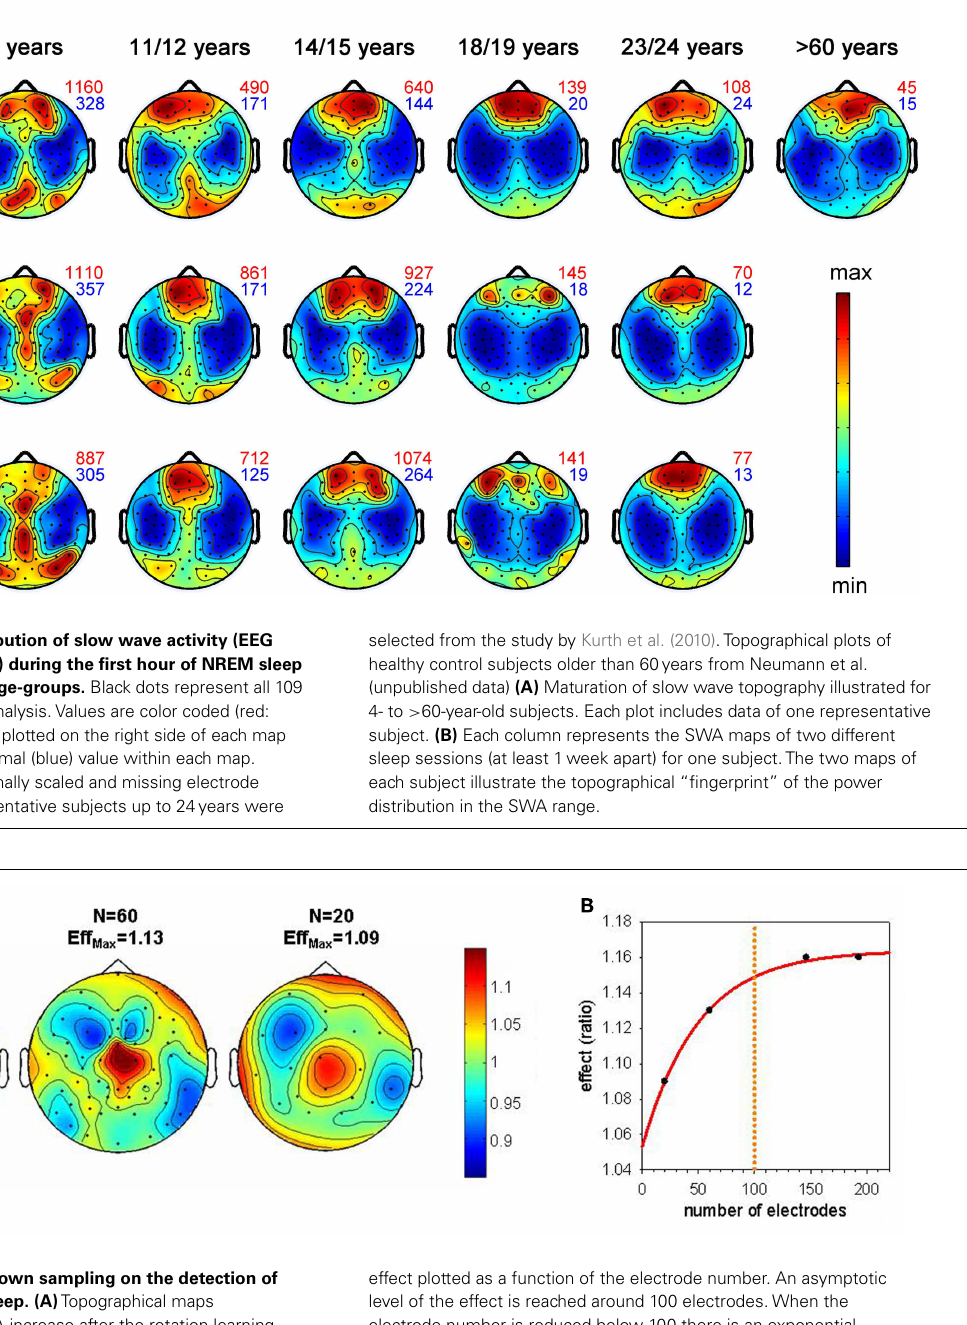
effect plotted as a function of the electrode number. An asymptotic level of the effect is reached around 100 electrodes.When the electrode number is reduced below 100 there is an exponential decrease in the size of the effect.This pronounced decrease in the effect decreases the probability to detect a local change in SWA in a significant cluster of